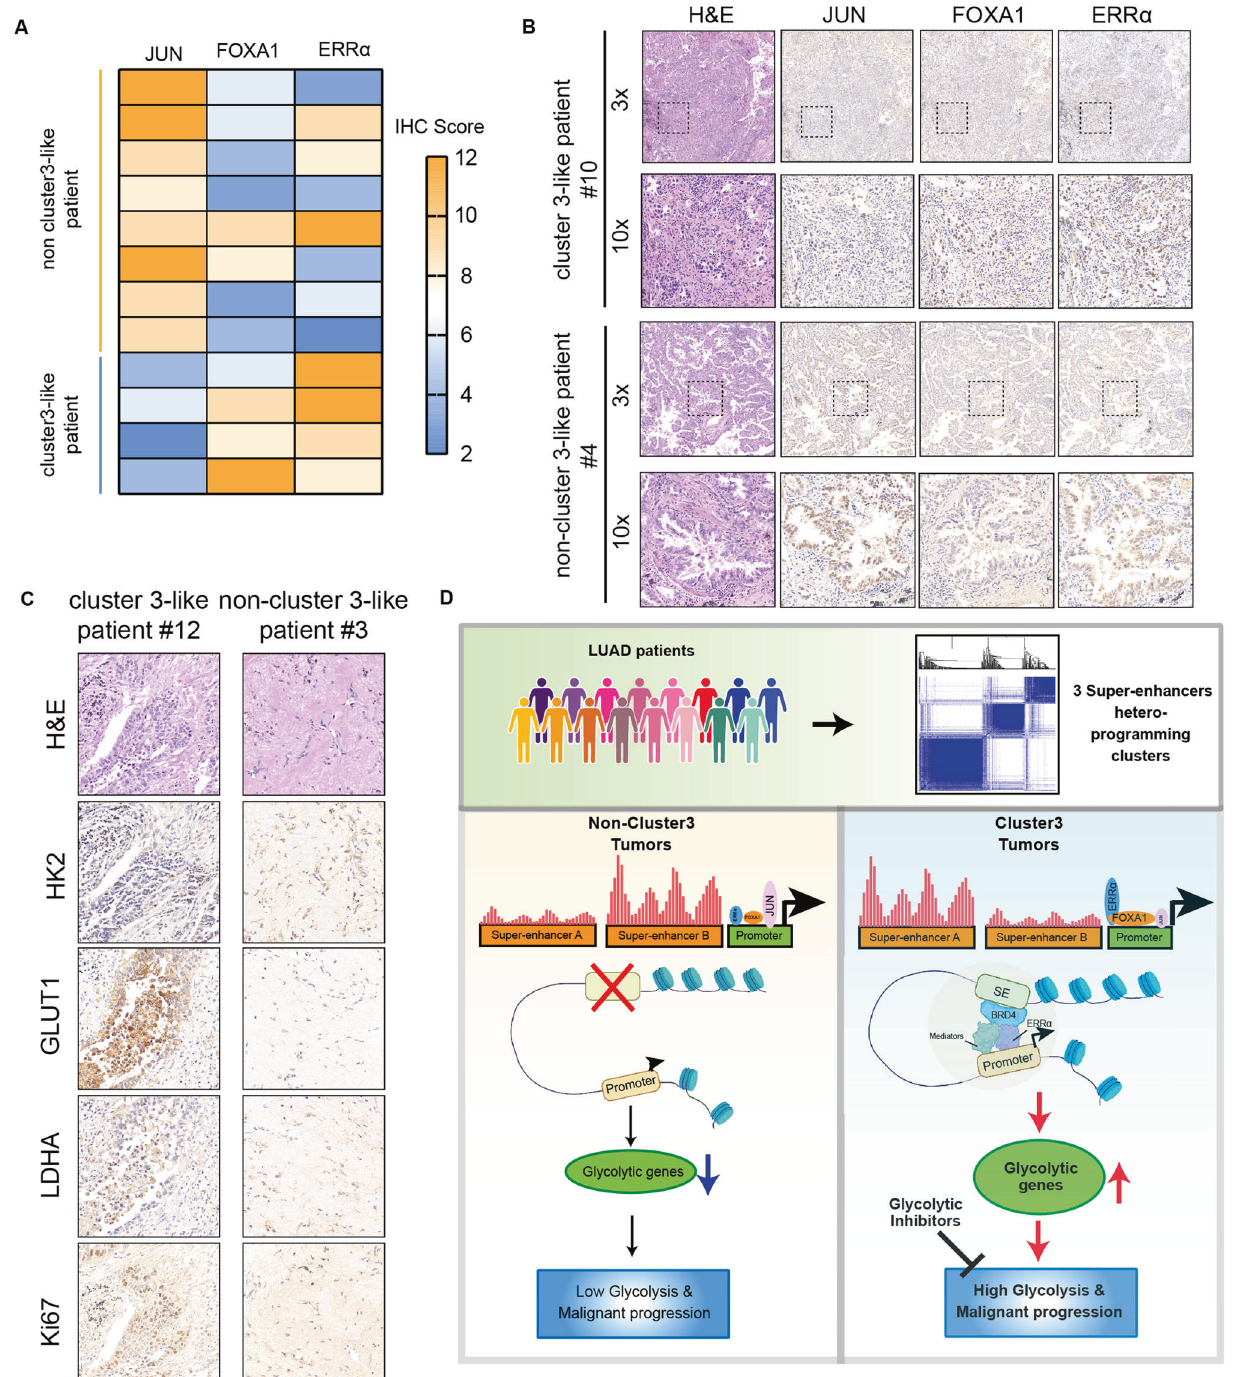
Fig. 6 Core TFs expression indicated the glycolysis capacity in LUAD patients. A Heatmap displaying the IHC scores of 3 core TFs expression in LUAD samples from the Jiangsu Cancer Hospital, with a representative image shown in ( B ). C Representative IHC staining image of HK2, GLUT1, LDHA and Ki67 in LUAD samples from the Jiangsu Cancer Hospital. D We used a large-scale clinical seRNA expression pro fi le cohort and unsupervised clustering to obtain the three clusters. Through the enrichment of TF motifs, we identi fi ed the core TFs that regulate the transcription of each cluster, namely ERR α , FOXA1 and JUN. We con fi rmed that ERR α in cluster 3 can act as a cofactor of BRD4 to assist SE- promoter loops in SE hijacking, activating glycolysis-related target gene expression, and promoting glycolysis and malignant progression of tumor expression levels were positively correlated (Table S8 and Fig. Core TFs expression indicated the glycolysis capacity in LUAD S6E). We divided those patients based on the expression levels of patients the core TFs in those 12 LUAD tissues (Figs. 6A, B and S6F). We measured the mRNA and protein expression levels of the three Consistent with the previous results, cluster 3-like tumors showed core TFs in 12 LUAD patients, and found that, as expected, their